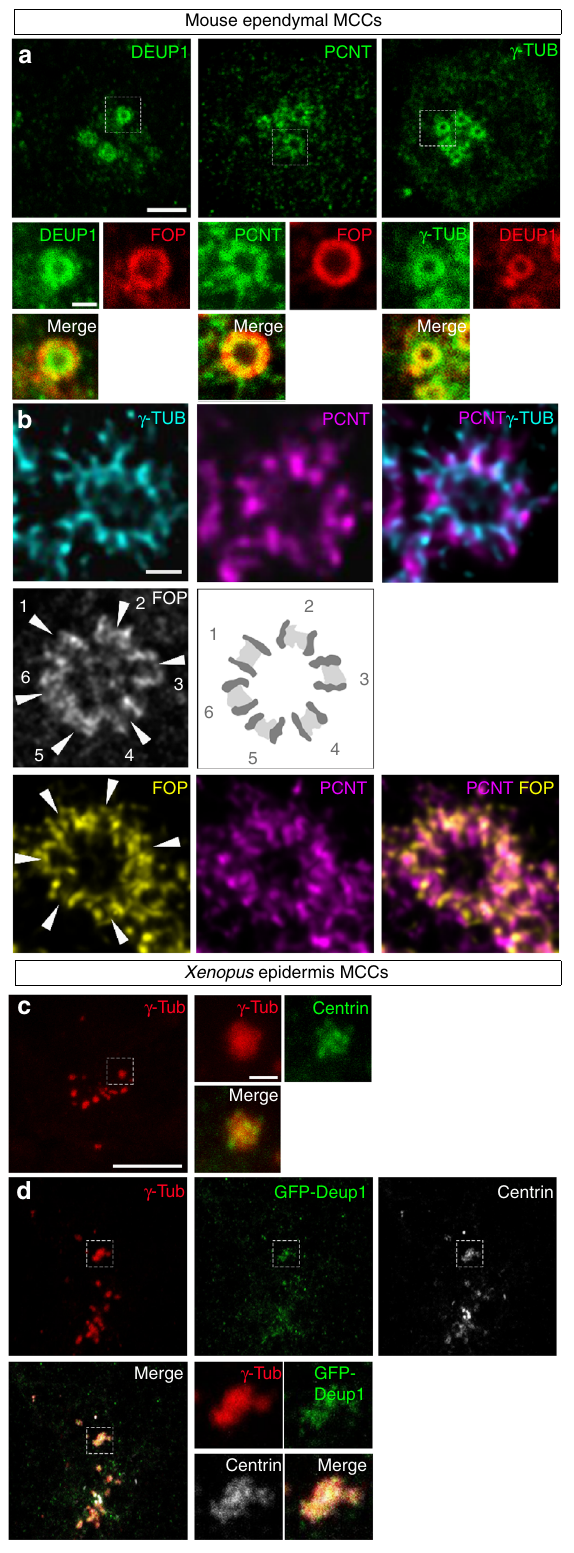
CDC20B associates to vertebrate deuterosomes . We then ana- lyzed the subcellular localization of CDC20B protein in deu- terosome stage mouse and Xenopus MCCs. In immature mouse tracheal MCCs, double immuno fl uorescence revealed the asso- ciation of CDC20B to DEUP1-positive deuterosomes (Fig. 3a).